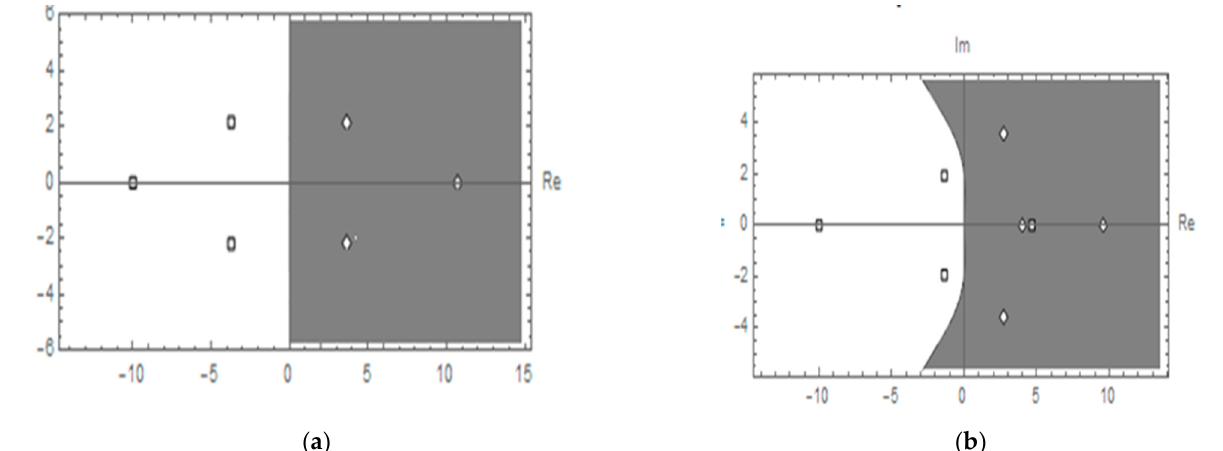
Figure 2. Stability regions of method (9) ( a ) and method (11) ( b ) with poles inclusive. Regions of absolute stability of the continuous block implicit hybrid methods which are A-stable and symmetric about the x -axis, since the enclosed Figures of the regions contain the complex plane outside the